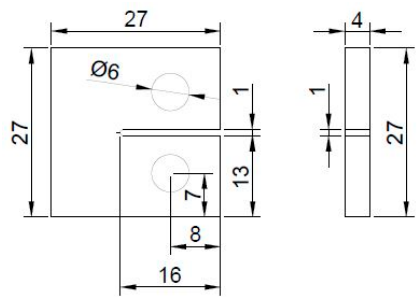
Figure 6. Dimensions (in mm) of the compact tension (CT) specimen.